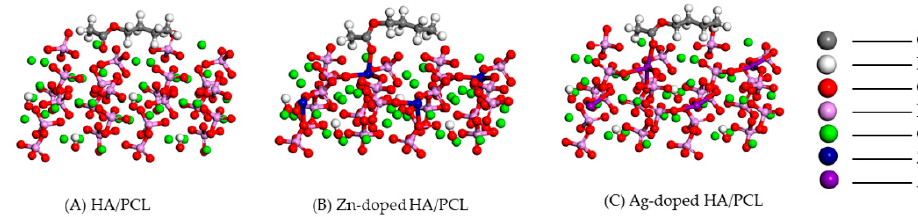
Figure 4. Adsorption structure of PCL on different surfaces of various HA structures.